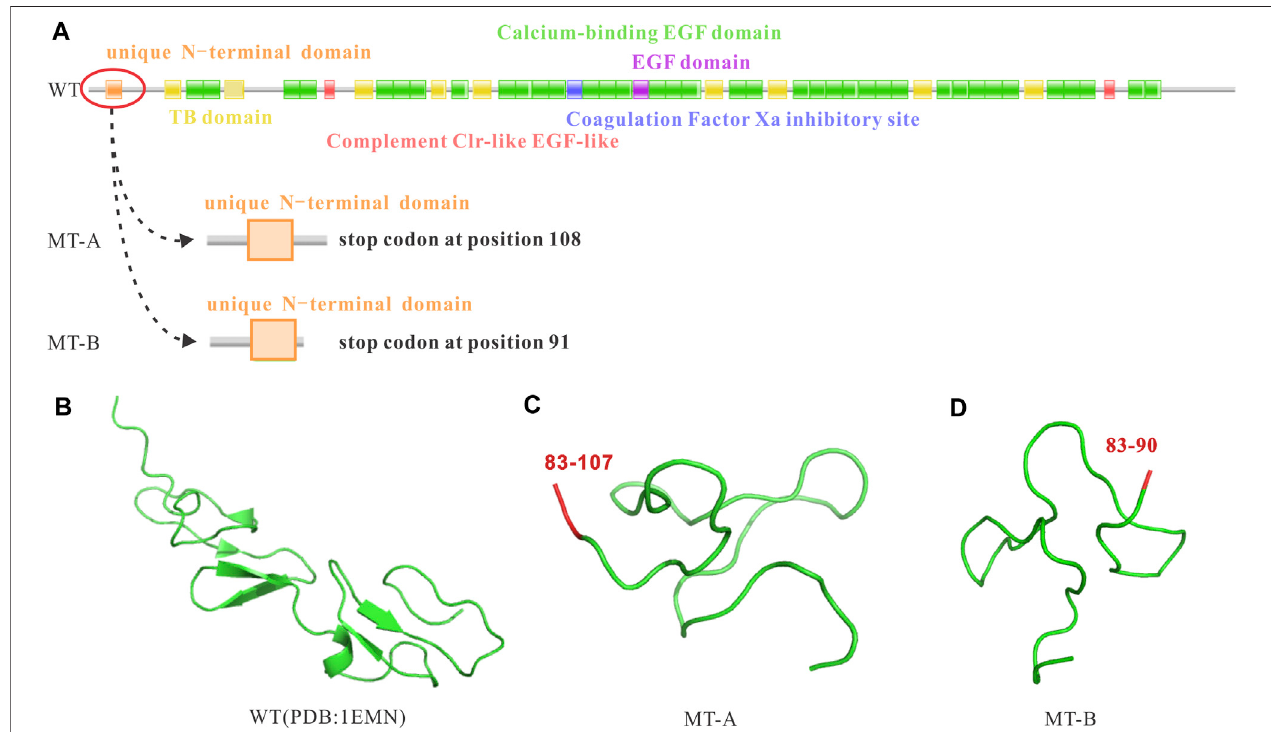
FIGURE4| Impact oftheFBN1c.248-3C > Gvariantonthereading frameresultinginprematurestop codonsandtruncatedproteins. (A) WT readingframe,MT-A causingaprematurestopcodonatposition108,andMT-Bcausingaprematurestopcodonatposition91; (B) WTprotein; (C) MT-Aresultinginatruncatedprotein; (D) MT-B resulting in a truncated